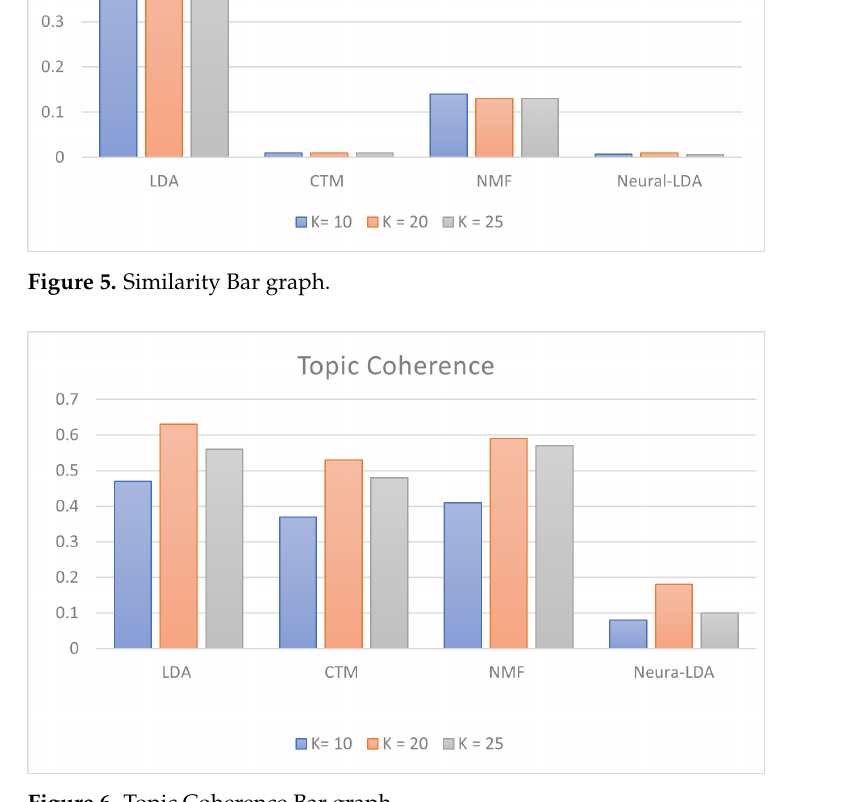
Figure 6. Topic Coherence Bar graph.